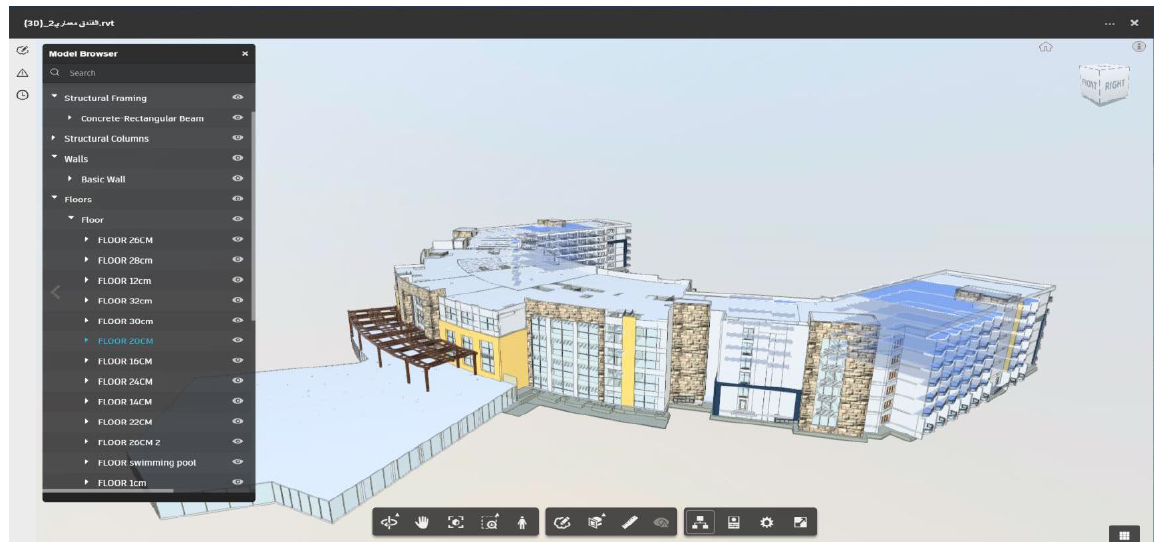
Figure 5: BIM 360 Doc (3D Arch. Walk Through View – The military